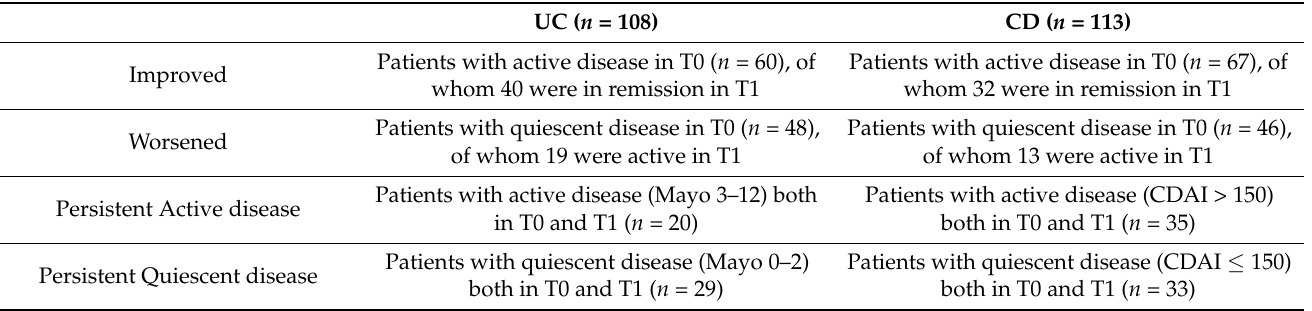
Table 1. DA change-related groups from T0 to